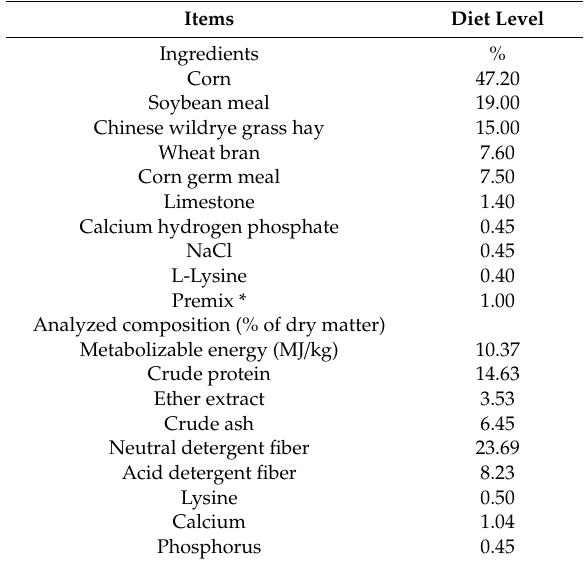
Table 1. The composition and ingredients in the experimental diets.